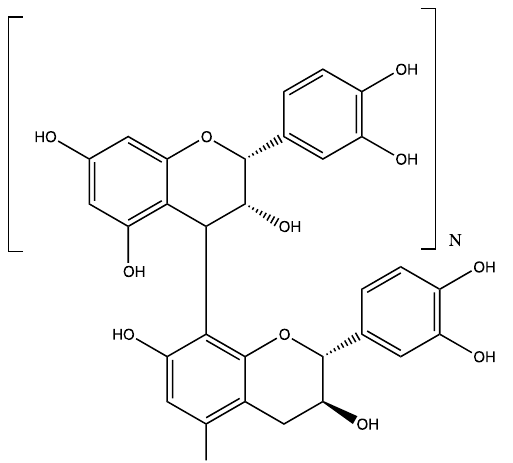
Figure 14. Proanthocyanidins from Xylocarpus moluccensis